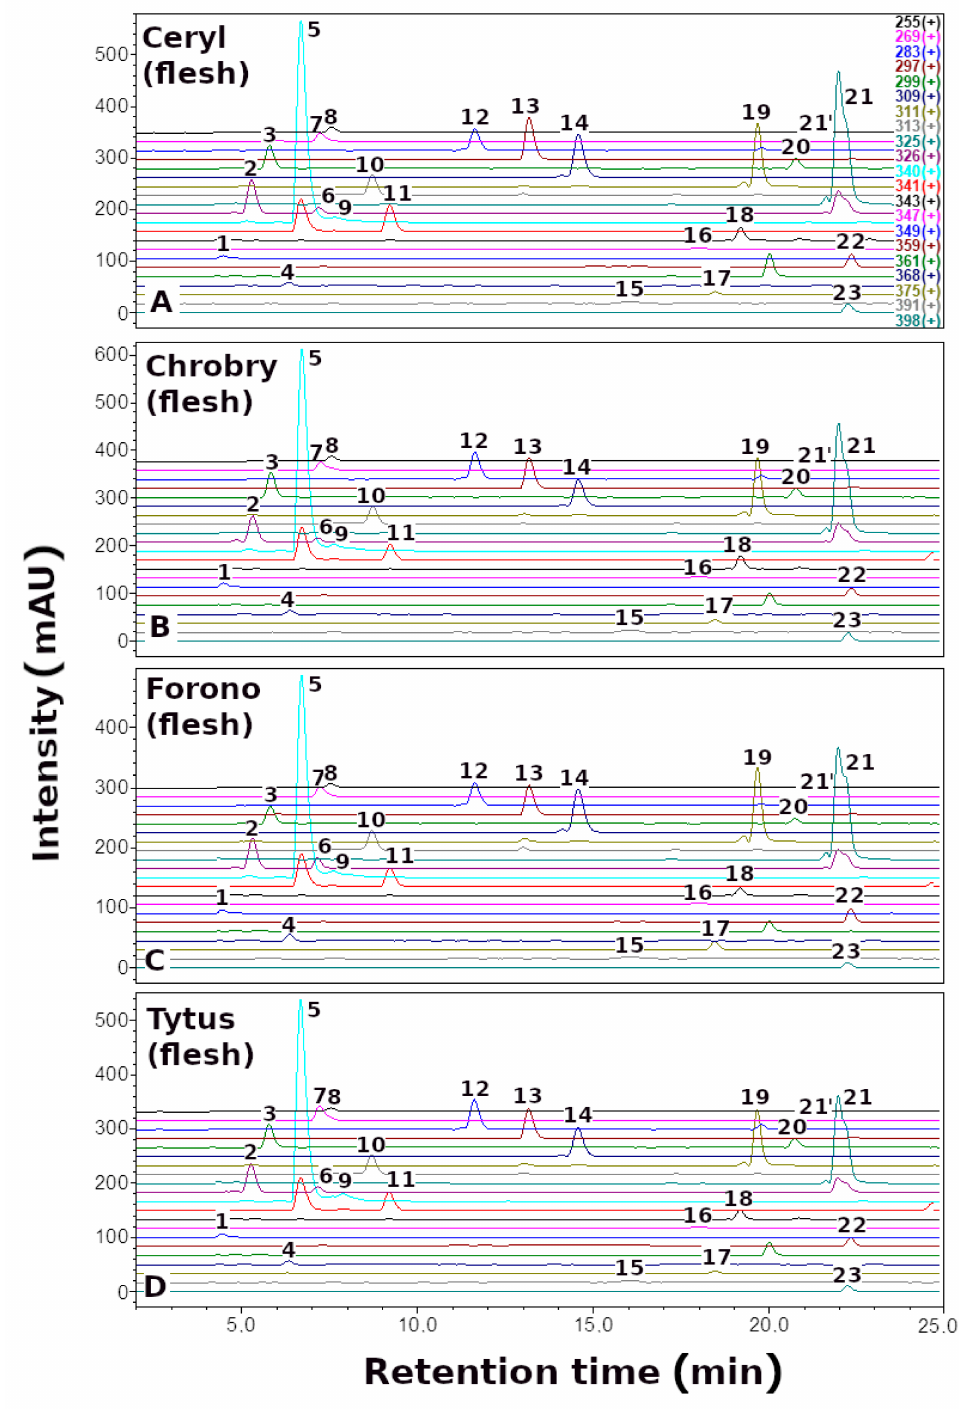
Figure 4. Selected-ion monitoring chromatogram (ESI-MS) in positive ion mode for betaxanthins of red Beta vulgaris L. flesh: ( A ) Ceryl, ( B ) Chrobry, ( C ) Forono, and ( D ) Tytus. Numbers and names are available in Table